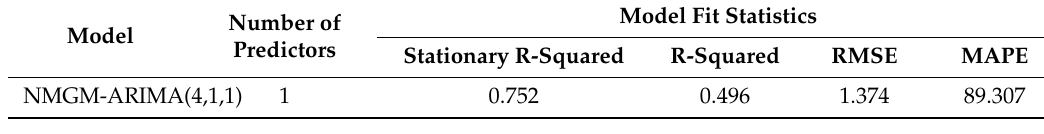
Table 12. Parameters of the goodness of fit for the NMGM-ARIMA (4,1,1).